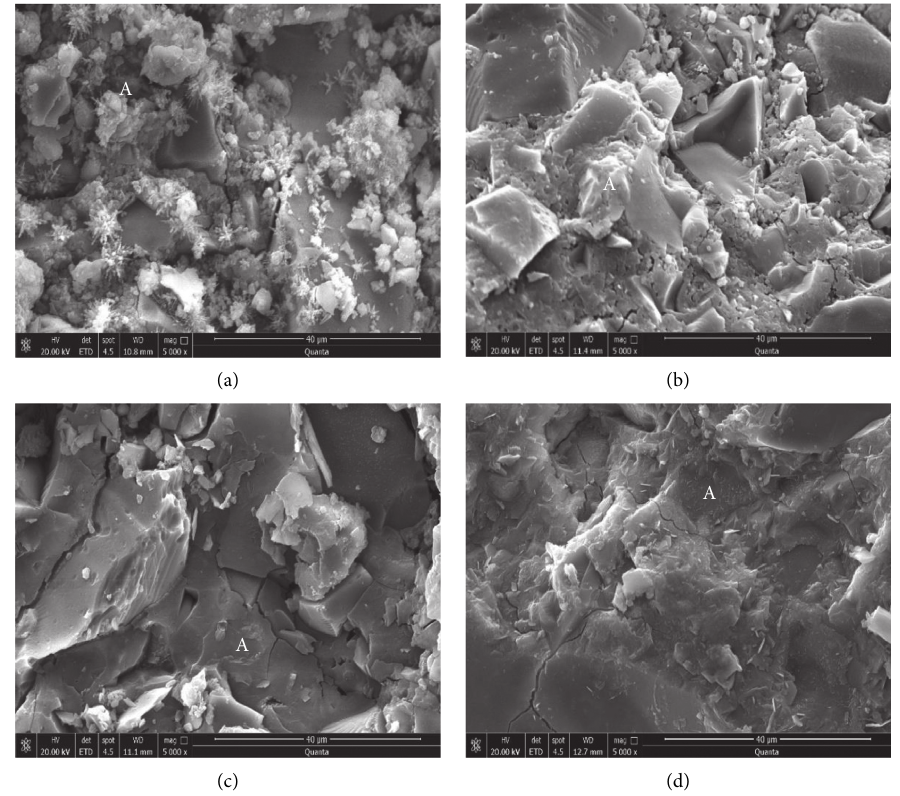
Figure 7: SEM images of NS13-N2-J1 (magnification: 5000x) at one day (a); three days (b); seven days (c); 28 days (d).